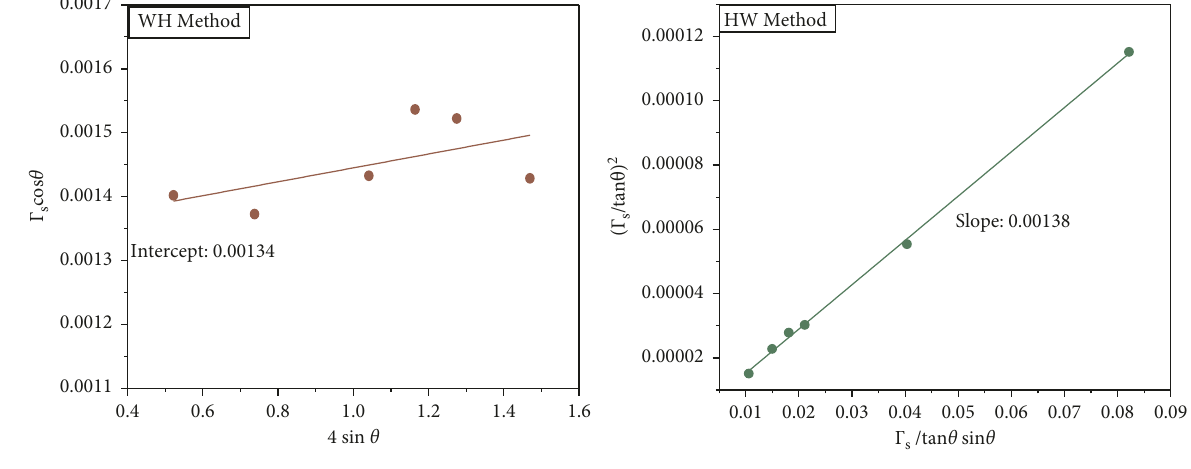
Figure 3: Crystallite size estimation via WH and HW methods.